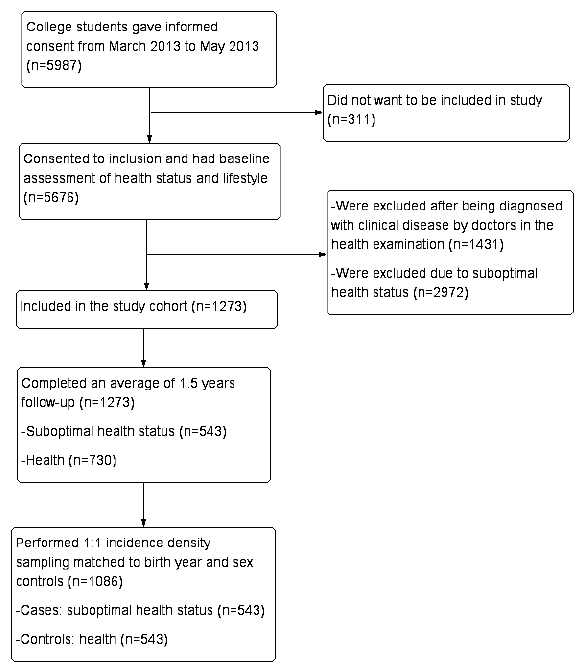
Figure 1. Flow of eligible participants in this nested case-control study.